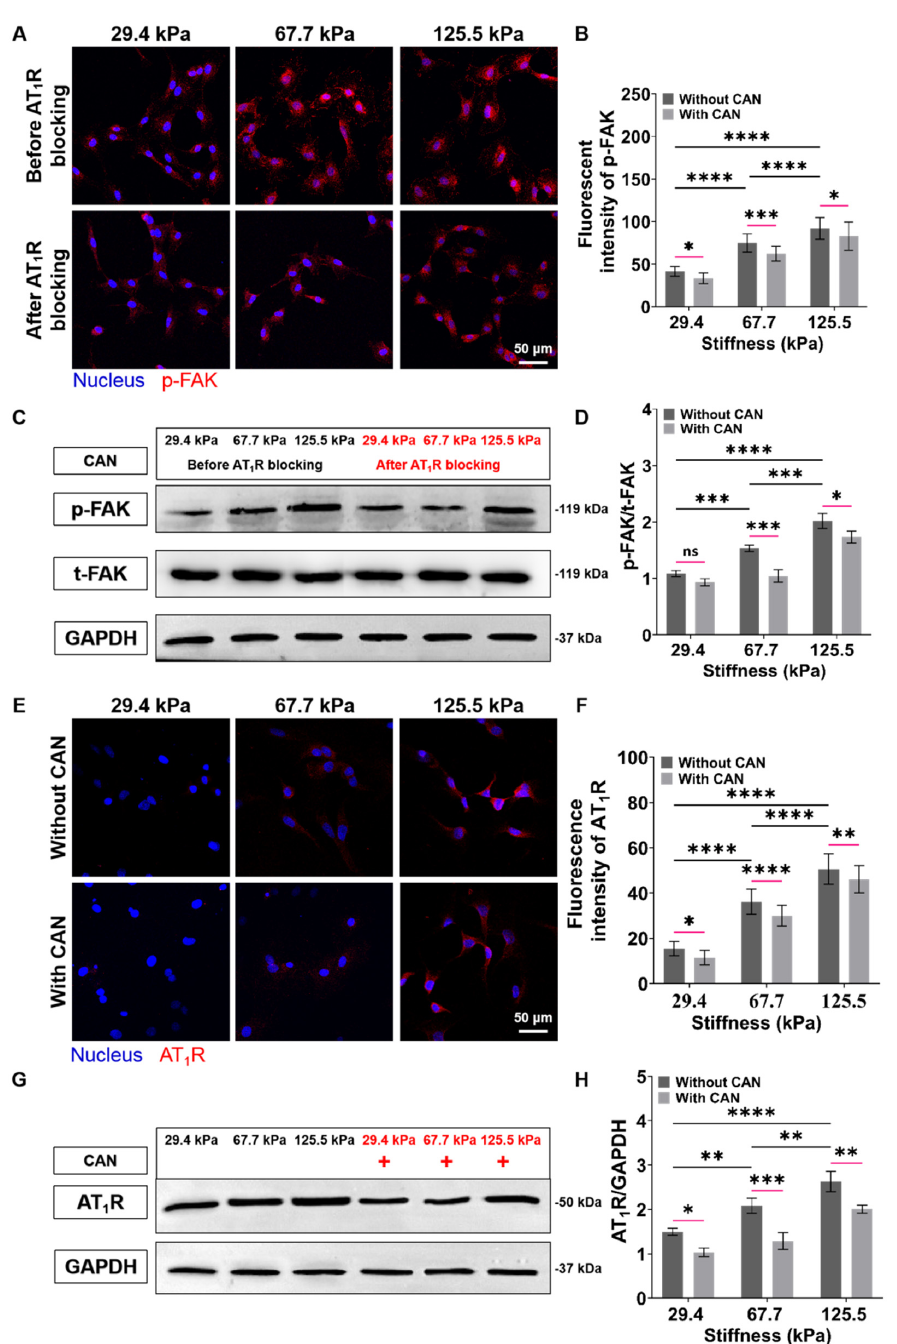
Figure 8. Characterization results of expressions of p-FAK and AT 1 R of CFs on PA gels with a stiffness of 29.4, 67.7, and 125.5 kPa. ( A ) p-FAK fluorescence images of CFs on PA gels with different stiffness before and after AT 1 R blocking. ( B ) Statistical histogram of p-FAK fluorescence intensities expressed by CFs ( n > 3). ( C ) Relative protein levels of p-FAK of CFs on PA gels with different stiffness before and after AT 1 R blocking determined by western blotting analysis. ( D ) Statistical histogram of protein gray values of p-FAK ( n = 3). ( E ) AT 1 R fluorescence images of CFs on PA gels with different stiffness without and with CAN treatment. ( F ) Statistical histogram of AT 1 R fluorescence intensities expressed by CFs ( n > 3). ( G ) Relative protein levels of AT 1 R of CFs on PA gels with different stiffness without and with CAN treatment determined by western blotting analysis. ( H ) Statistical histogram of protein gray values of AT 1 R ( n = 3). Data are shown as means ± SEM. ns, no significant difference, * p < 0.05, ** p < 0.01, *** p < 0.001, and **** p < 0.0001 determined by two-way